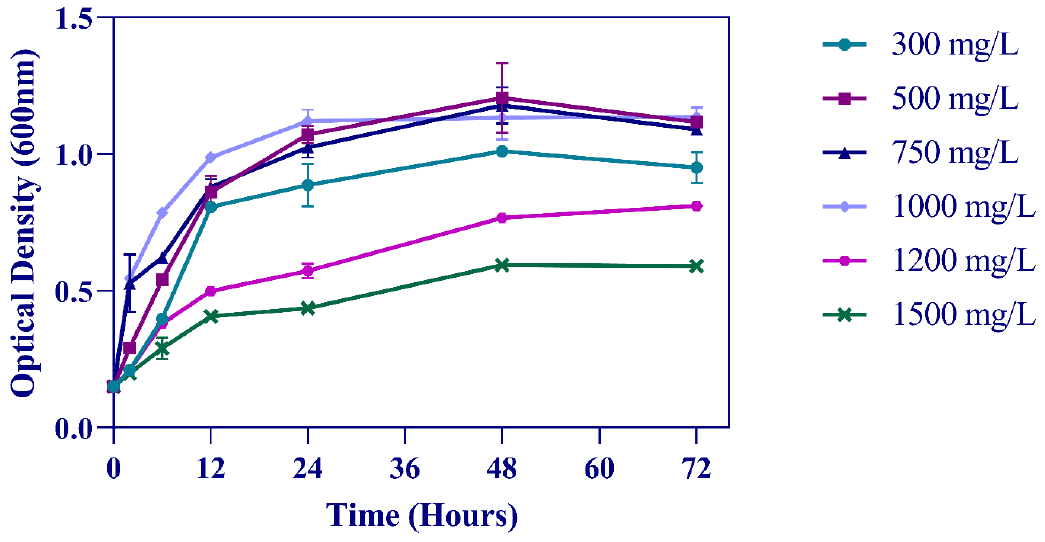
Figure 1. Sphe3 growth curves in different phenol concentrations. Solid lines with circle, square, triangle, rhombus, polygon, and ex symbols represent measurements of Sphe3 growth in the presence of 300, 500, 750, 1000, 1200, and 1500 mg/L phenol, respectively. Error bars indicate standard deviation of three measurements.